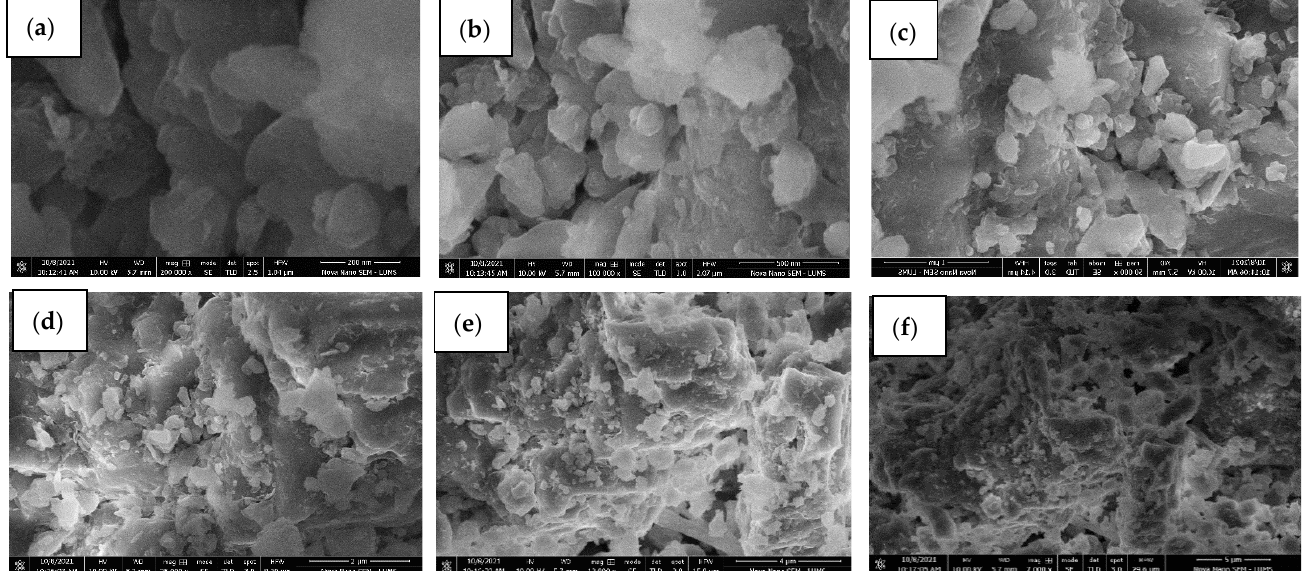
Figure 6. SEM images of pure golden marble powder at various resolutions, ( a ) 200 nm, ( b ) 500 nm,